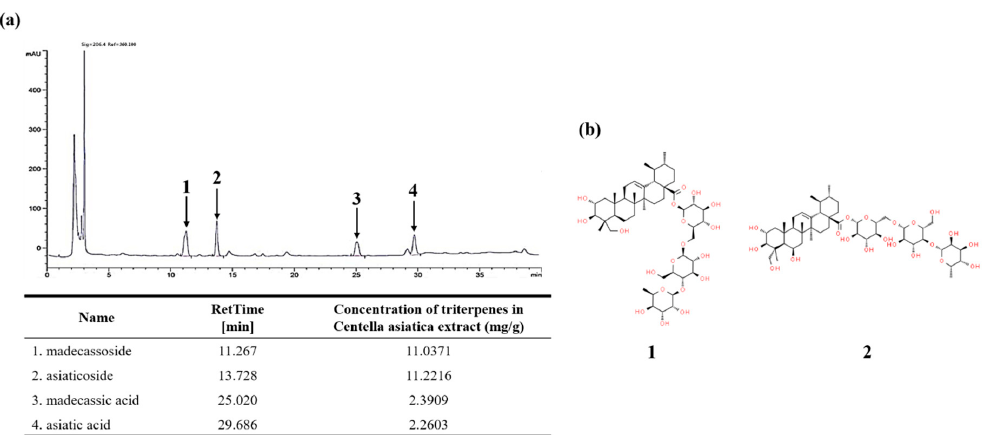
Figure 2. ( a ) High-performance liquid chromatography (HPLC) chromatography of CA; ( b ) Chemical structures of major components. The HPLC analysis on CA was performed with a reverse-phase column (SunFire C18, 4.6 × 250 mm, 5-um diameter; Waters, Milford, MA, USA). The column was preserved under 40 °C at the flow rate of 1 mL/min and the injection volume of 10 µL. 1: madecassoside (MO), 2: asiaticoside (AO), 3: madecassic acid (MA), 4: asiatic acid (AA).